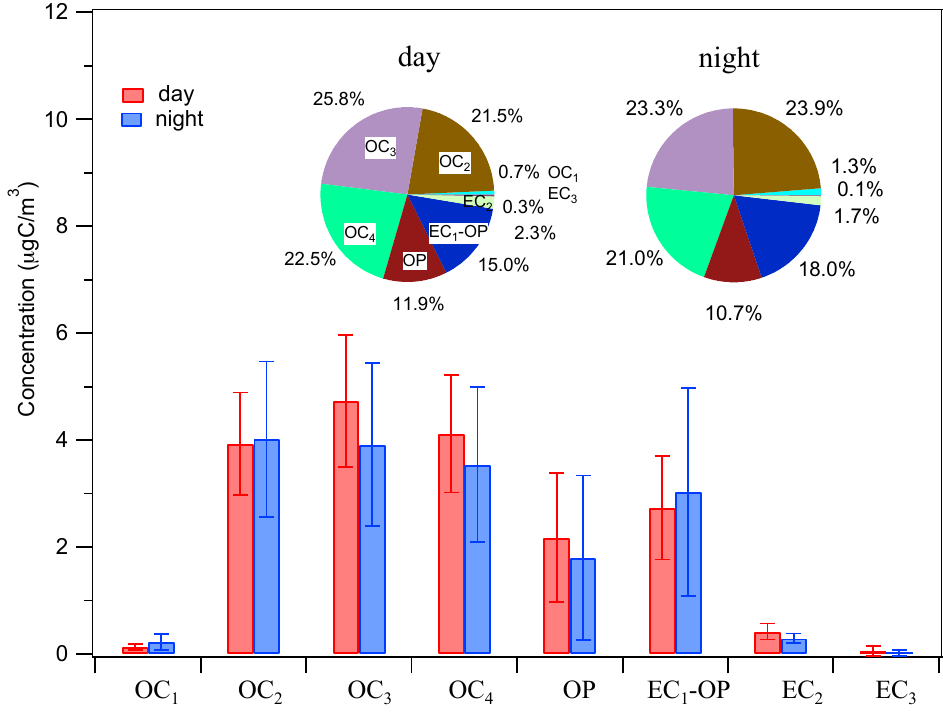
Figure 3. Average mass percentages of eight fractions of carbon to the total carbon mass (OC + EC). OC, EC, and OP stand for organic carbon, elemental carbon, and pyrolyzed carbon, respectively. Error bar represents the standard deviation.